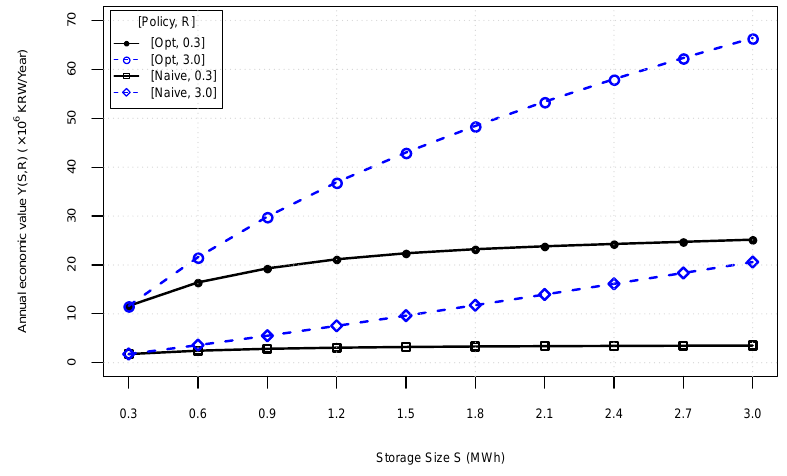
Figure 11. Annual economic values Y ( S , R ) of the optimal policy vs. that of the naive policy with different storage capacity